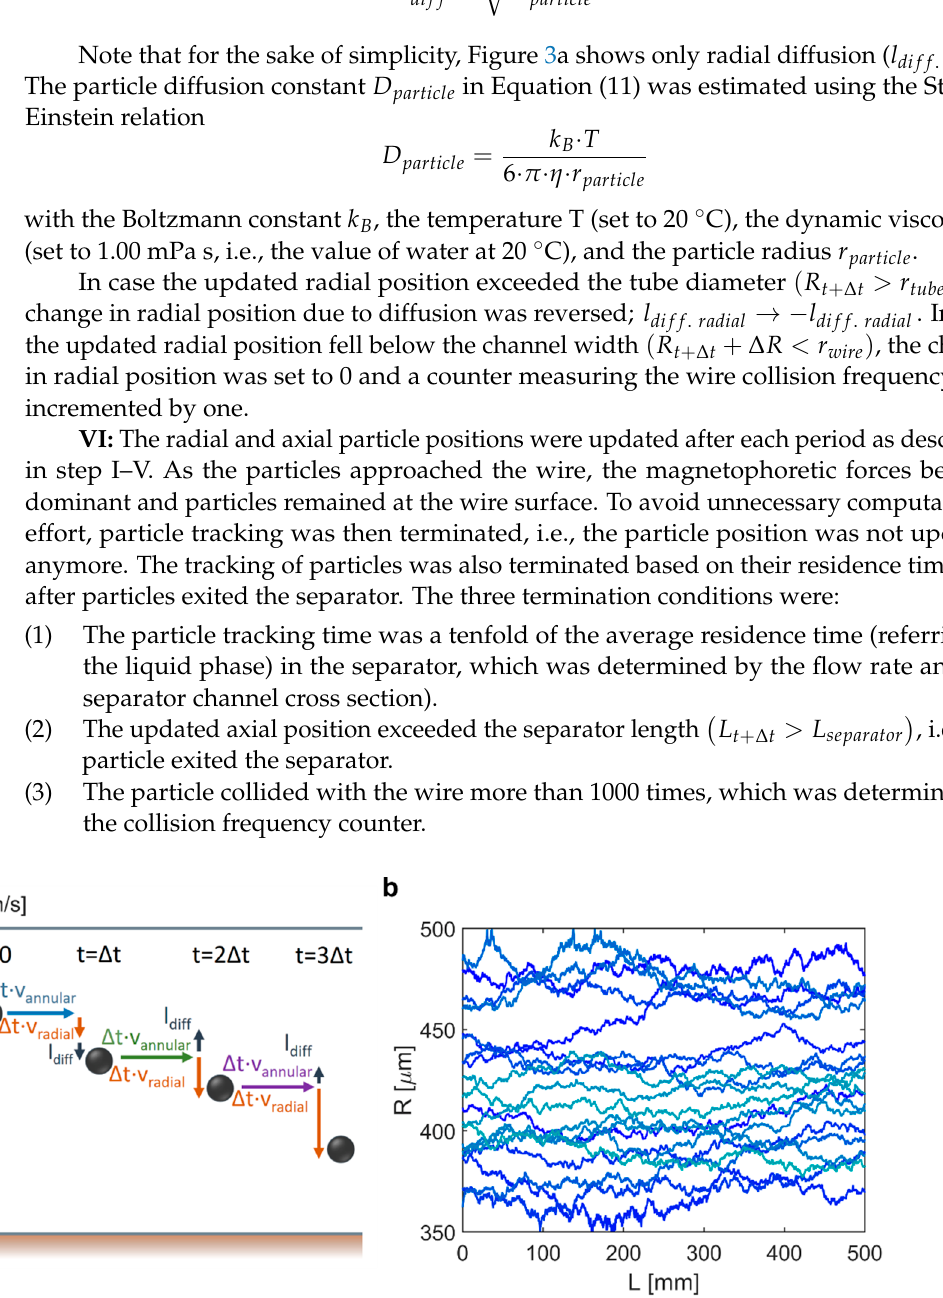
Figure 3. ( a ) Annular velocity profile ( V = 0.5 mL/min, r tube = 500 µ m , r wire = 350 µ m ( r wire / r tube = 0.7) and concept of particle-tracking algorithm. ( b ) 20 trajectories of 250 nm IONPs in the magnetic separator of the same dimensions at a flow rate of 0.15 mL/min in the absence of a magnetic field.